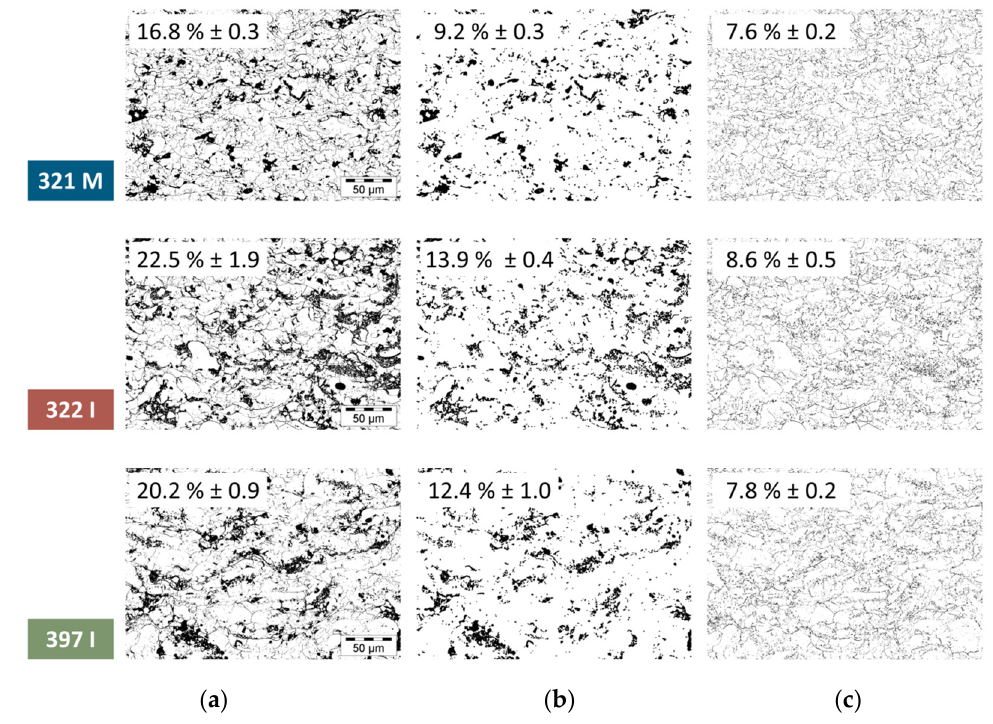
Figure 8. Typical examples of porosities ( a ) total porosity; ( b )coarse porosity fraction; ( c ) fine porosity fraction) for the three investigated LZ powders processed by TriplexPro™-210 torch at low power (22 kW) and with Ar–He plasma gas mixture (binarized back-scattered electron images); porosity volume percentages were averaged from three images.